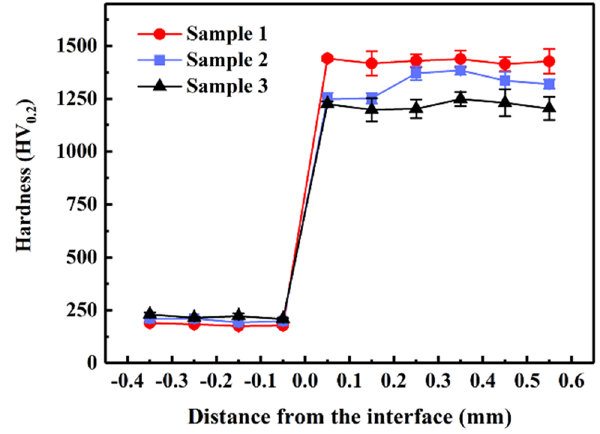
Figure 6: Distribution of microhardness of